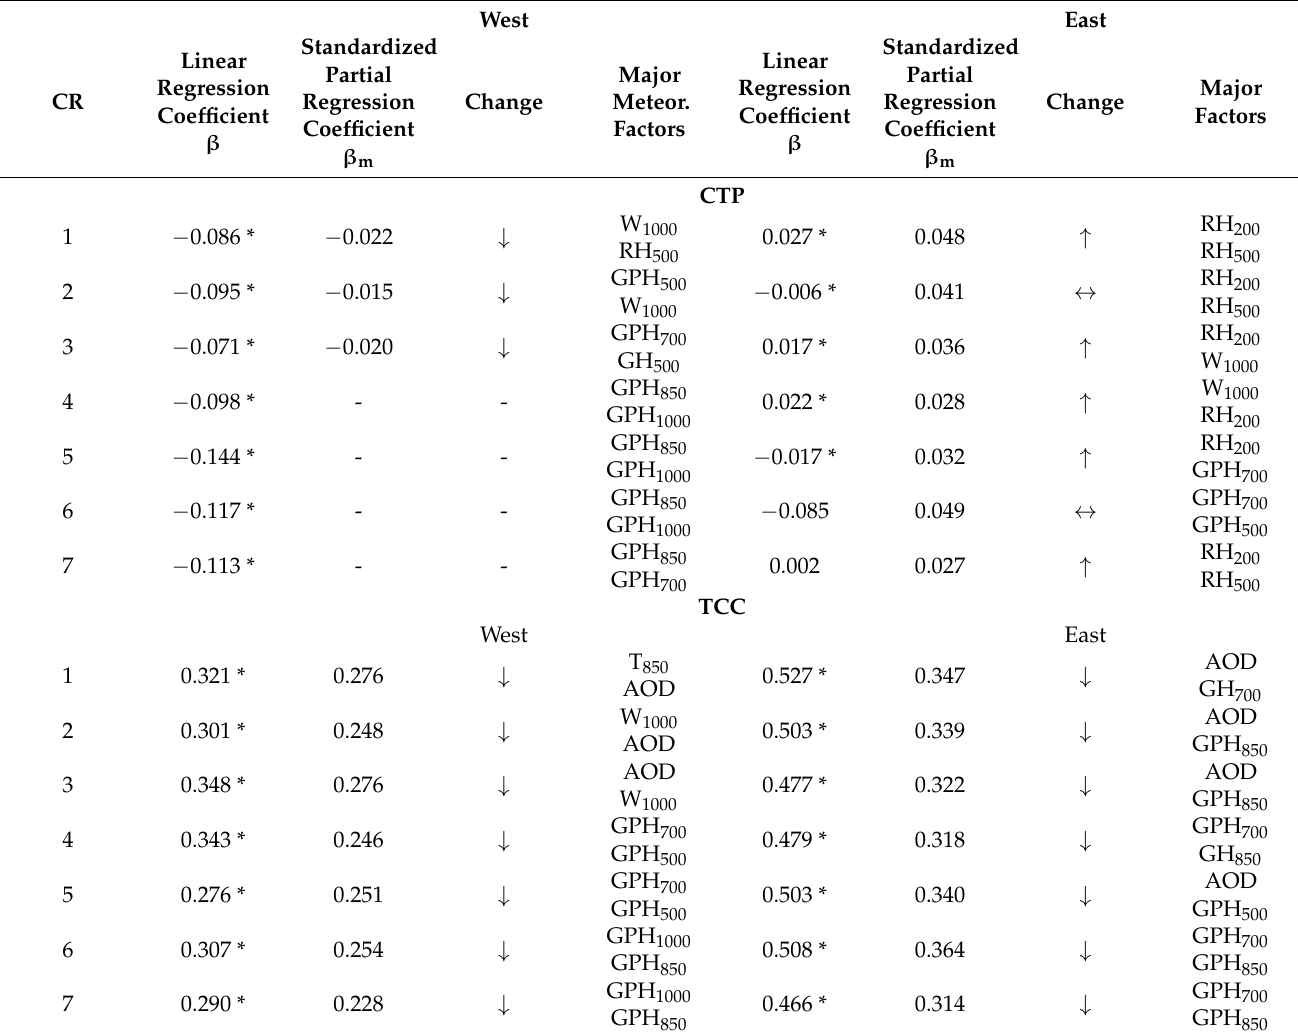
Table 3. The linear regression coefficient ( β ) for the AOD–CTP/TCC relationship, standardized partial regression coefficient ( β m ) when considering meteorological factors for the AOD − CTP/TCC relationship, and the major factors affecting